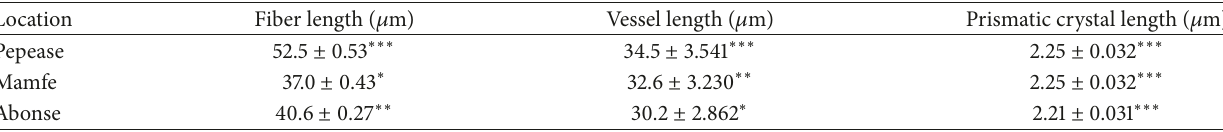
Table 4: Mean dimensions of the fiber length, vessel element length, and prismatic crystal length (adapted from Ameyaw [31]).